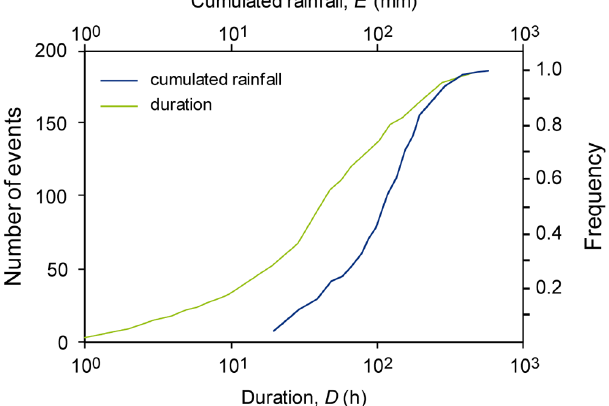
Fig. 3. Frequency curves of the rainfall duration D (in hours) and the cumulated event rainfall E (in mm) for the 186 rainfall ( D,E) conditions that resulted in shallow landslides in Calabria in the 16- year period from January 1996 to September 2011.